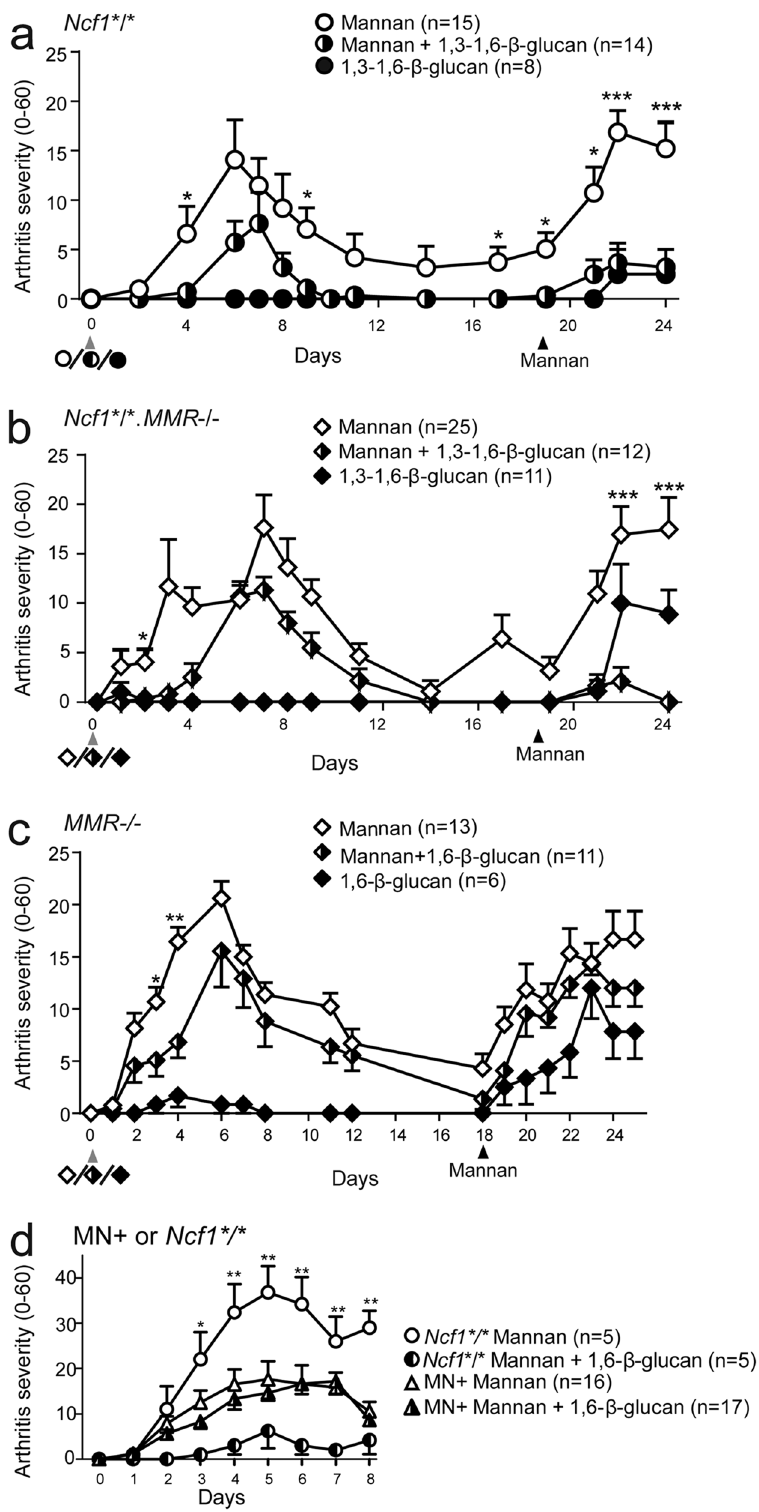
Fig. 3 Macrophages mediate the protective effect of β -glucan in MIP. Arthritis severity was followed in MIP induced in Ncf1 -de fi cient ( a ), Ncf1 and MMR - de fi cient ( b ) or MMR -de fi cient ( c ) mice with or without co-administration of 1,3 – 1,6- β -glucan (5 mg; a , b ) or 1,6- β -glucan (2 mg; c ). After 18 days, MIP was re-induced by the administration of mannan to investigate the long-term effects of β -glucans. MIP was induced in MN + and Ncf1 -de fi cient mice ( d ) with or without co-administration of 1,6- β -glucan (2 mg) to investigate the effect of Ncf1 expressed under the human CD68 promoter on the Ncf1 -de fi cient background in MN + mice. The data are from three combined experiments in ( a , b , d ), and from one experiment in ( c , d ). Number of mice in each group is shown in parentheses in the legend. Statistical analyses were performed by Mann – Whitney test to compare the group receiving mannan with the group receiving mannan and β -glucan. * P < 0.05; ** P < 0.01; and *** P < 0.001. Results are presented as mean and error bars represent the